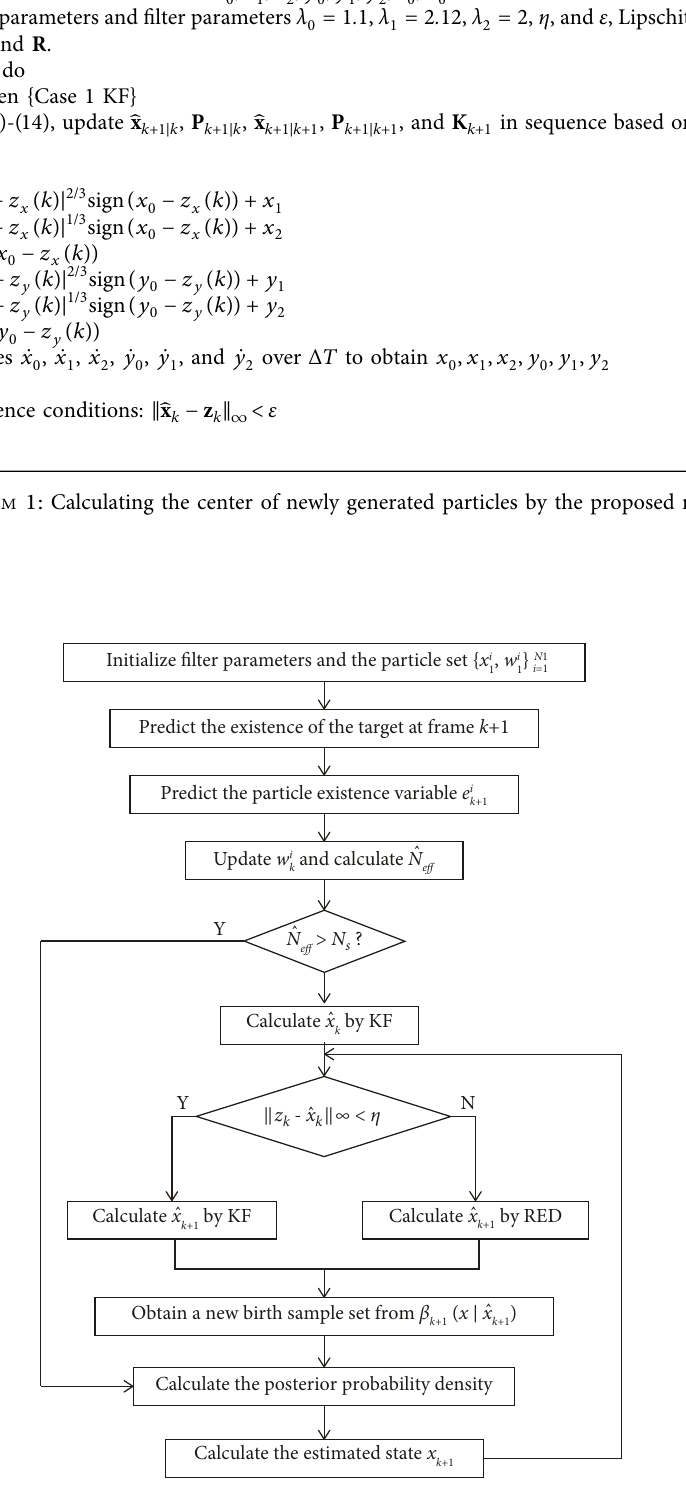
Figure 1: Flow chart of the proposed